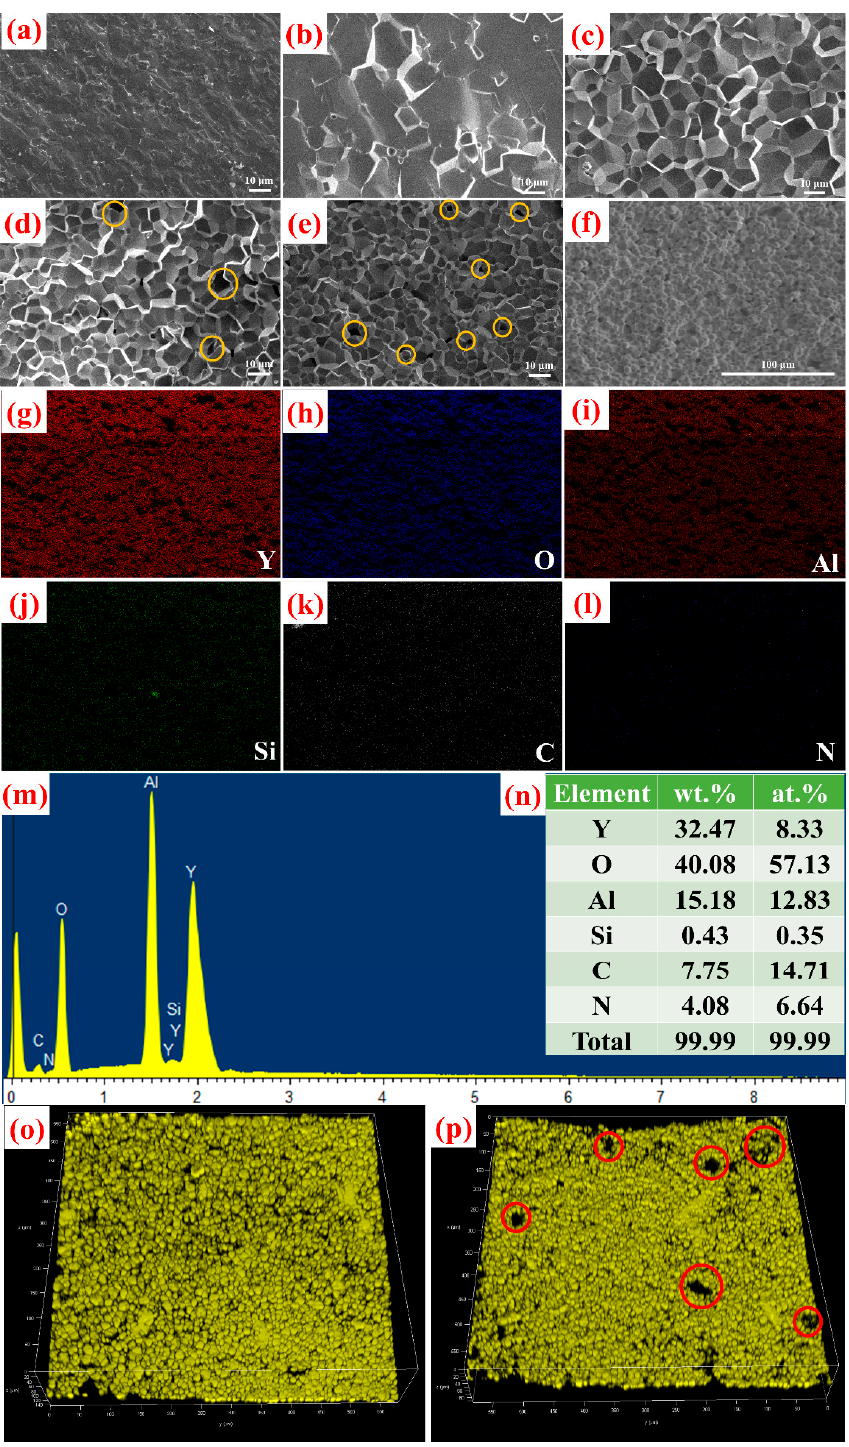
Figure 3. Microscopic information of the prepared samples. SEM images of the fracture surfaces of ( a ) 0SCASNE, ( b ) 0.05SCASNE, ( c ) 0.1SCASNE, ( d ) 0.5SCASNE and ( e ) 1SCASNE. ( f ) SEM image of 1SCASNE for EDS mapping, and ( g – n ) EDS elemental-mapping and proportion-analysis images of 1SCASNE; 3D-reconstruction CLSM images of ( o ) 0.05SCASNE and ( p ) 1SCASNE, respectively.